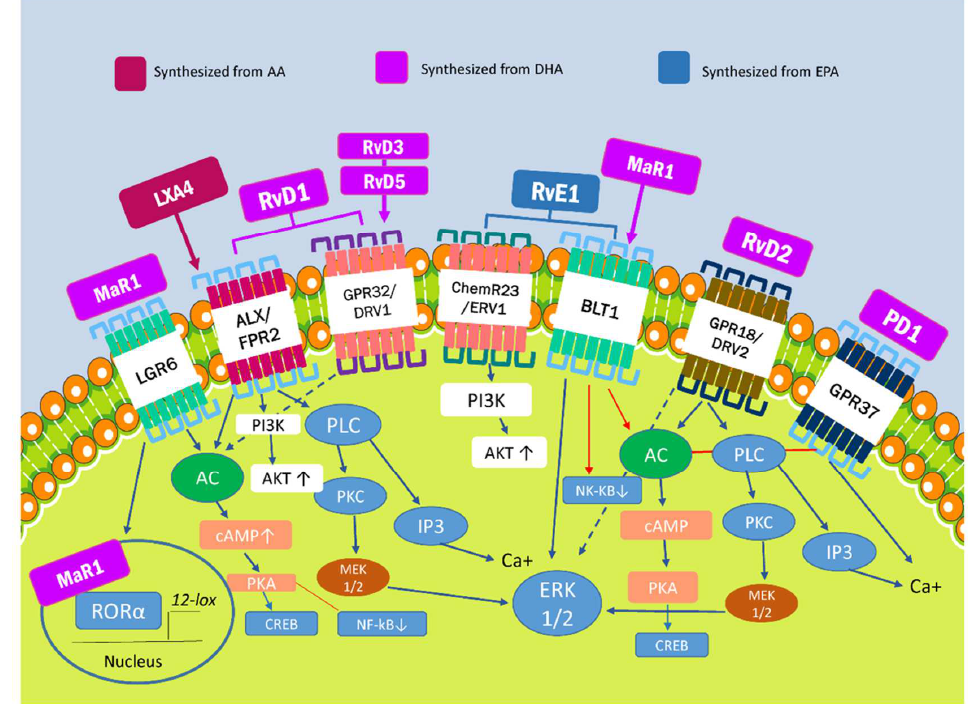
Figure 1. Lipoxins are derived from arachidonic acid, an ω-6 polyunsaturated fatty acid. The E- series resolvins are formed from the metabolism of the ω-3 polyunsaturated fatty eicosapentaenoic acid (EPA). Ohtter metabolites, E-series resolvins, maresins, and protectins are also formed from metabolism of the ω-3 polyunsaturated fatty acids docosahexaenoic acid (DHA). Finally, there are six known receptors belonging to the G protein-coupled receptor family for the SPMs, which are widely spread among human tissues, including leucocytes and endothelial cells. Each SPM represents a ligand for each of these receptors, frequently overlapping in matters of selectivity and biological functions. Figure 1 is presented to facilitate understanding the identified SPM receptors and the metabolic pathways involved with their proresolving biological functions, as described in murine models. AA: Arachidonic Acid. LXA4: Lipoxins A4. LXB4: Lipoxins B4. EPA: